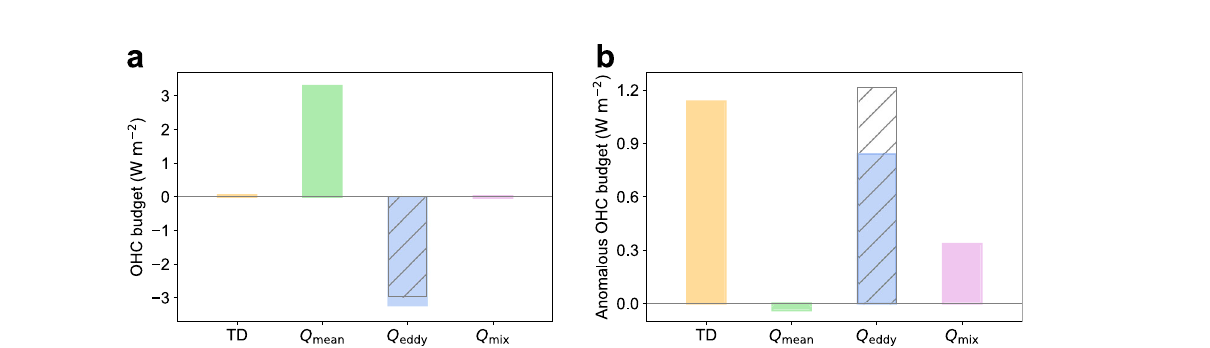
Fig. 3 | Offsetting effect of deep ocean warming on the ocean thermal energy conversion (OTEC) resource increase under a high carbon emission scenario derived from the high-resolution Community Earth System Model (CESM-H). a Time seriesof globalOTECpowerpotentialduring 2022 – 2100(bluedashedline) and its counterpart (OTEC-Fix power potential) computed by fi xing the tempera- ture at 1000m as its time-mean value during 1992 – 2021 (red line). Slope of the